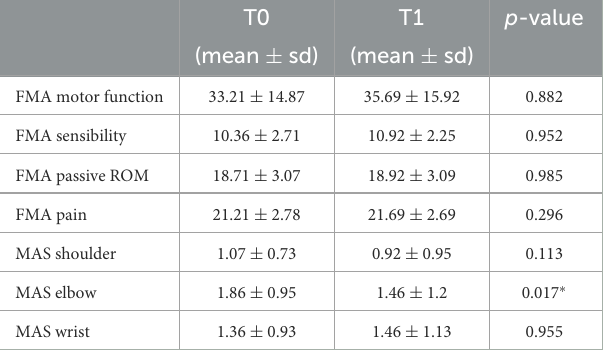
TABLE 2 FMA-UE and MAS comparison between T0 and T1. T0 T1 p -value